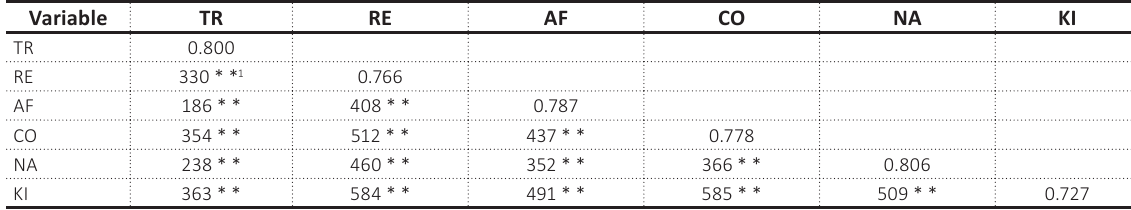
Table 6. Discriminant validity